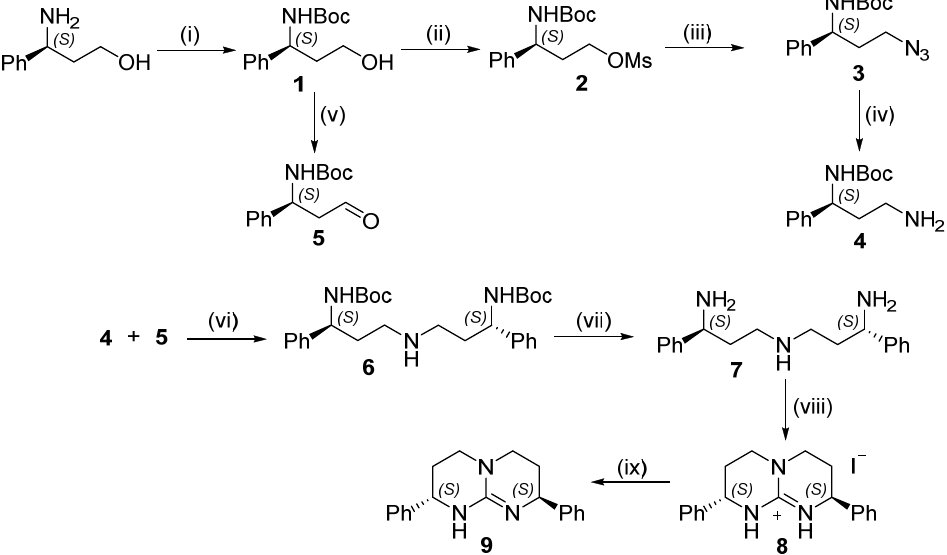
Scheme 1. Regents and conditions for synthesis of chiral DiPh-TBD: (i) Et 3 N, di- tert -butyl dicarbonate, Scheme 1 . Regents and conditions for synthesis of chiral DiPh ‐ TBD: (i) Et 3 N, di ‐ tert ‐ butyl dicarbonate,